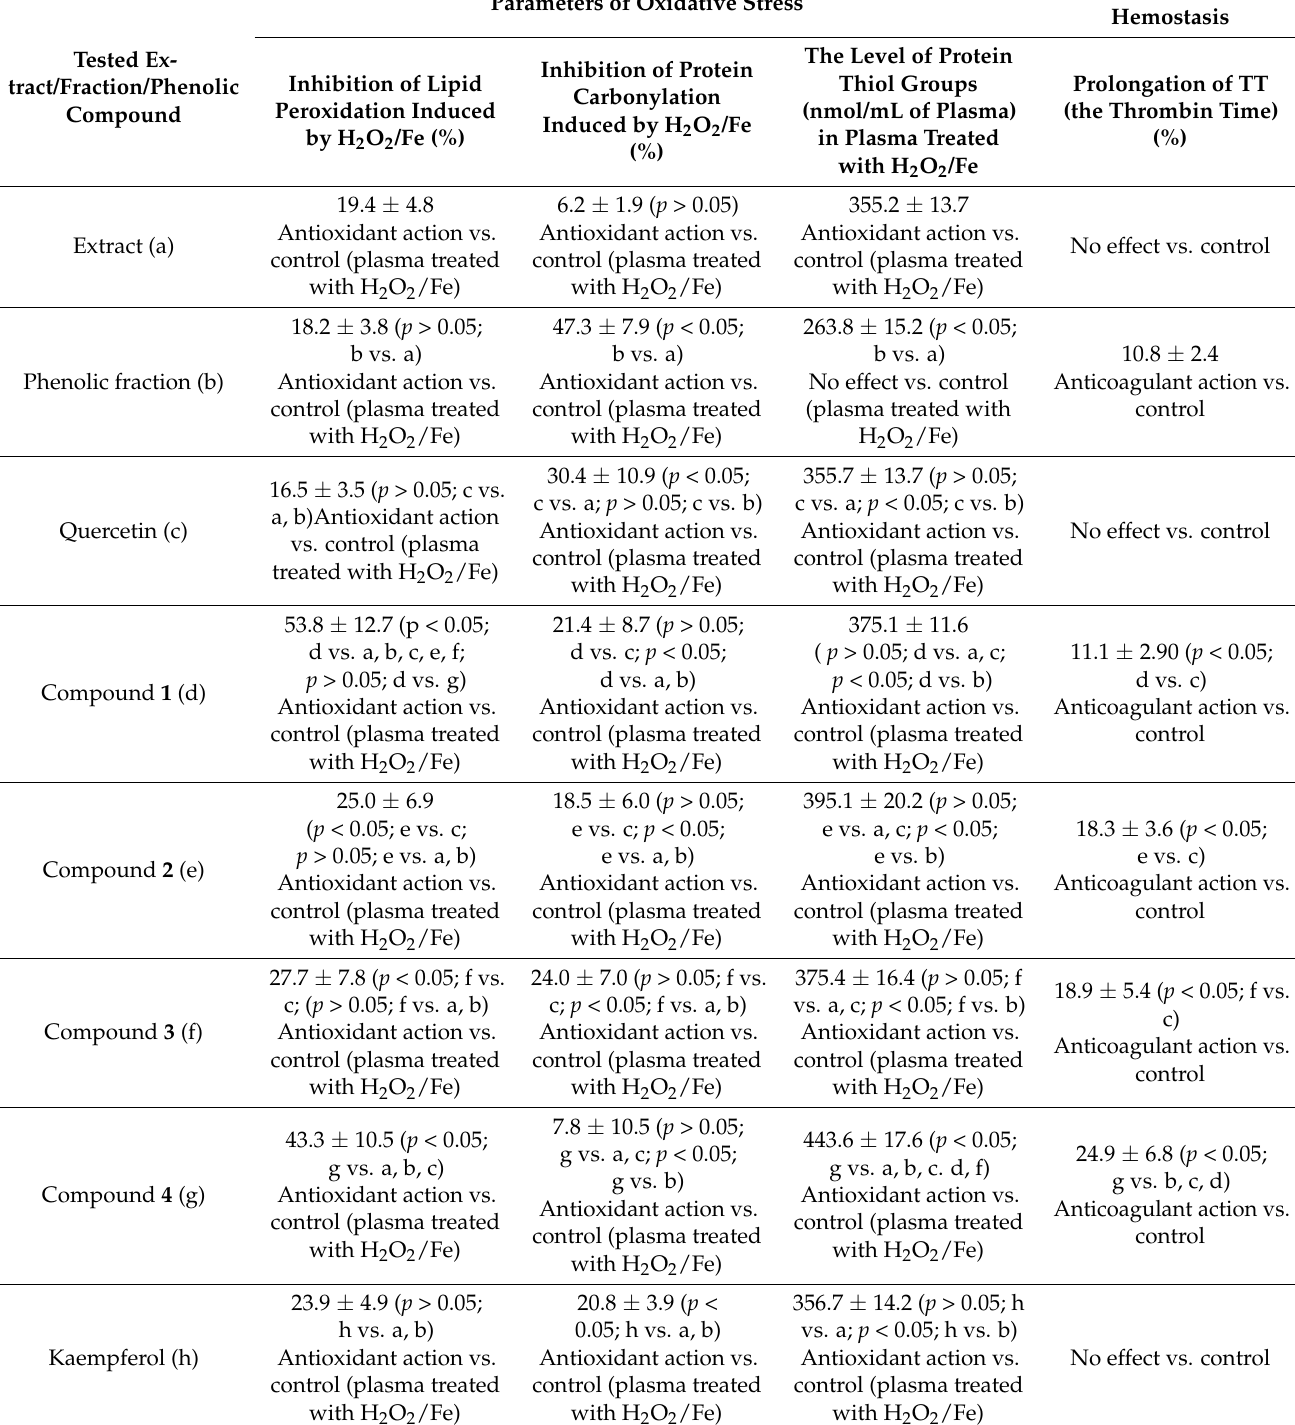
Table 2. Comparative effects of the crude extract, the phenolic fraction and flavonoids from lentil aerial parts and commercial flavonoids (quercetin and kaempferol) (50 µ g/mL) on selected parameters of oxidative stress and hemostasis. Data represent means ± SD of 6 independent